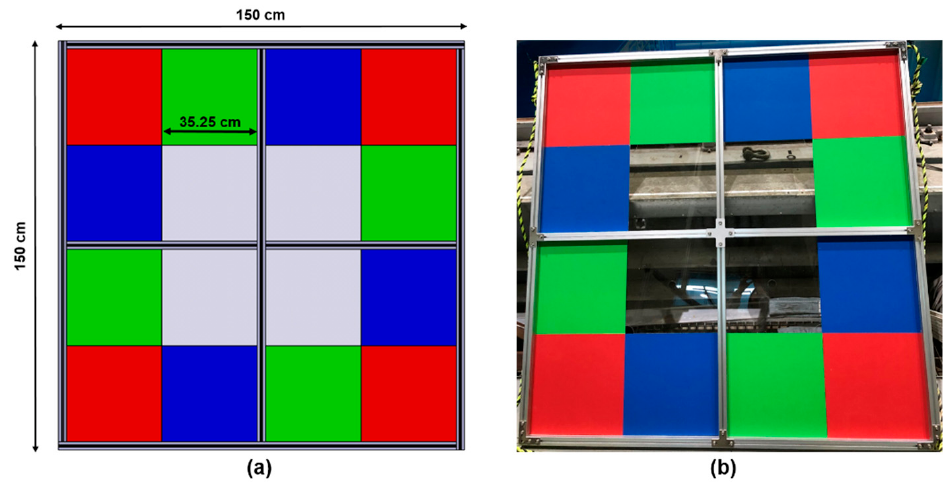
Figure 5. Calibration phantom, ( a ) schematic and ( b ) real RGB phantom for geometric calibration of underwater optical-sonar fusion system.